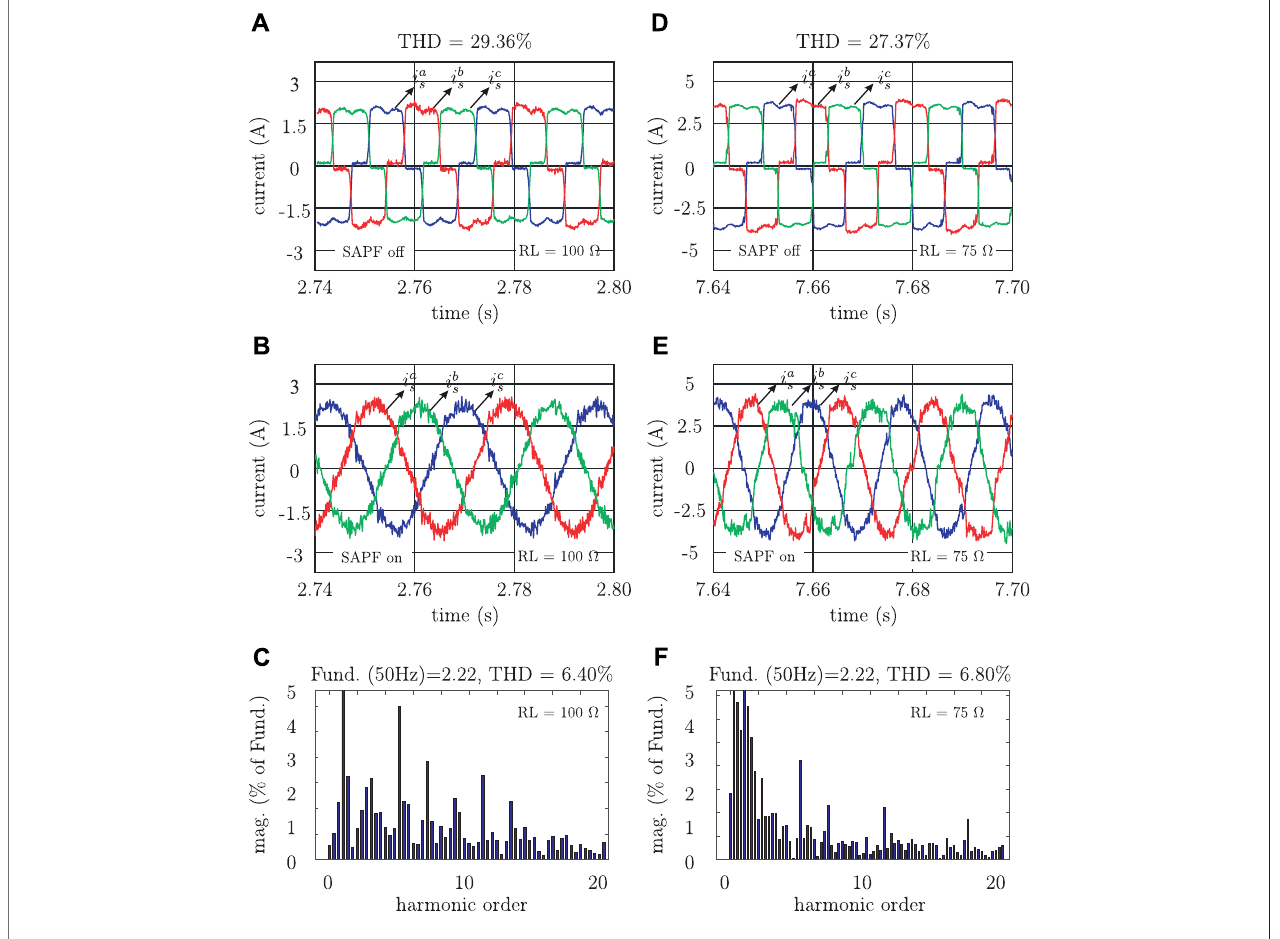
FIGURE 4 | Experimental results of source current harmonics compensation at the grid side considering a non-linear load and three operation points. (A) Uncompensated grid current for R L (cid:1) 100 Ω , (B) Compensated grid current for R L (cid:1) 100 Ω , (C) THD level of compensated grid current for R L (cid:1) 100 Ω .